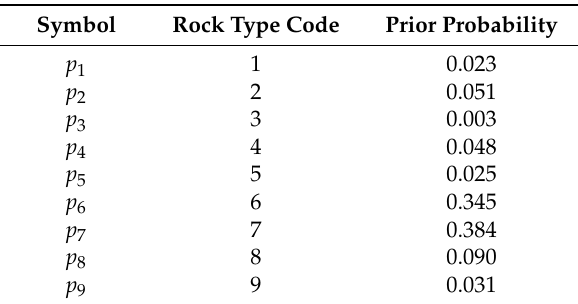
Table 4. Prior probability of each rock type.